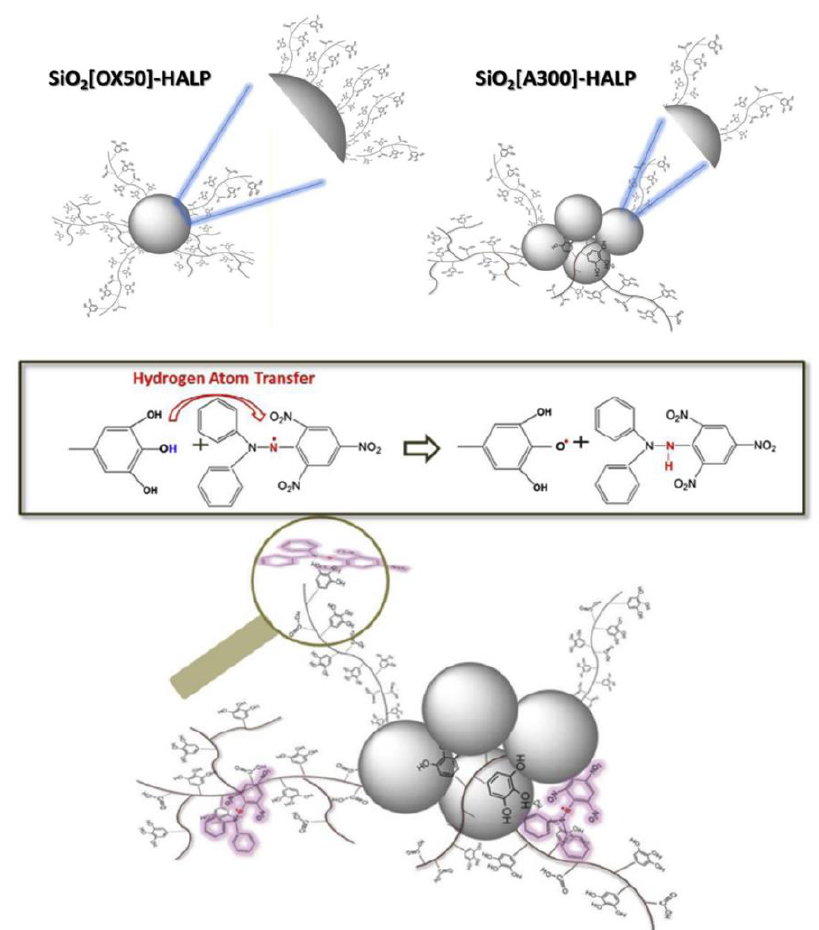
Figure 24. Schematic depiction of the antioxidant activity of engineered SiO 2 –HALP nanohybrids evaluated by assessing their kinetics for HAT towards DPPH radicals. Reprinted (adapted) with permission from [29].